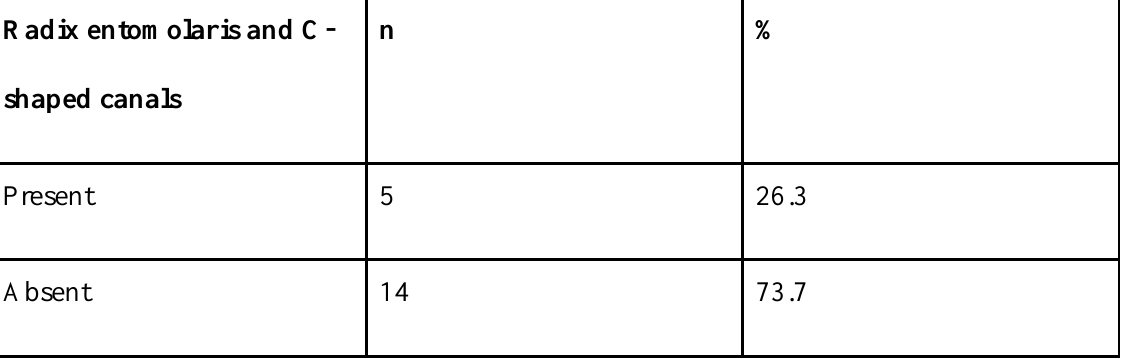
Prevalence of coexistence of radix entomolaris in mandibular first molars and C - shaped canals in mandibular second molars in pa�ents in terms of presence (n=19).